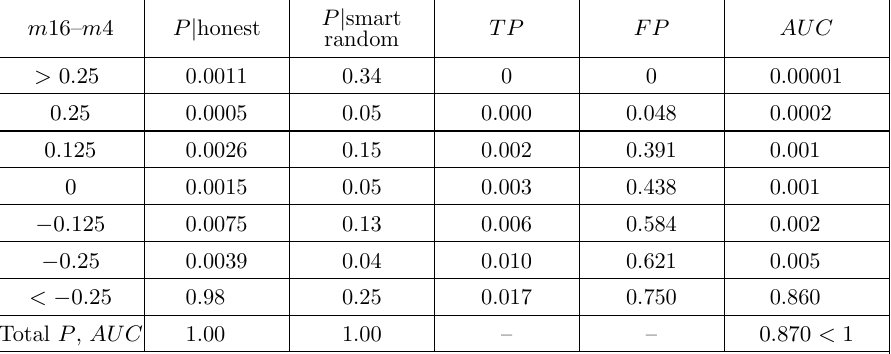
Table 5. Task of screening smart random response to the CES-D